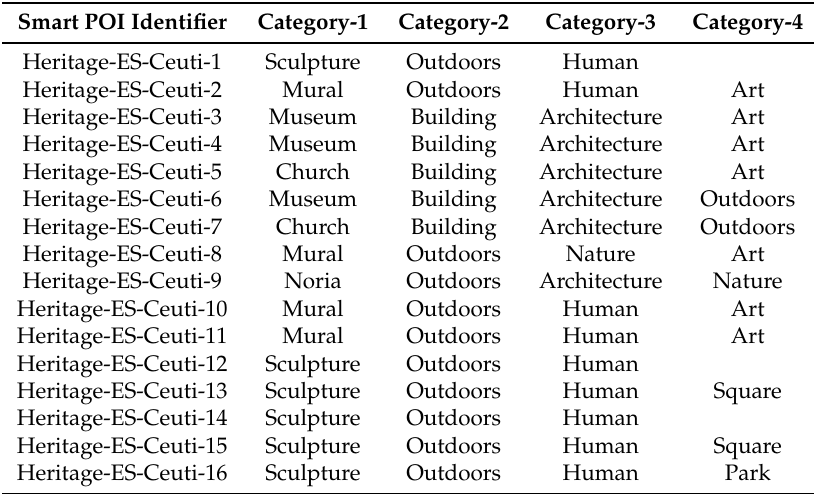
Table A3. Smart POIs’ categories